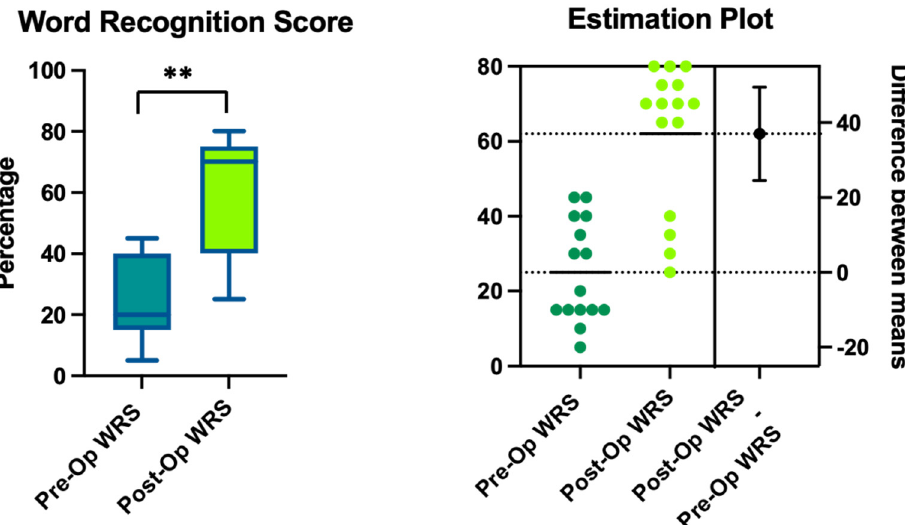
Figure 4. The results of the word recognition tests (word recognition score (WRS)) before (Pre-Op) and after surgery (Post-Op) at the 6-month follow-up. The higher values indicate the percentage of words recognized during the test; normal WRS scores are > 90%. The estimation plot shows the differences between the means, and the “**” indicates statistical significance of p < 0.0001.